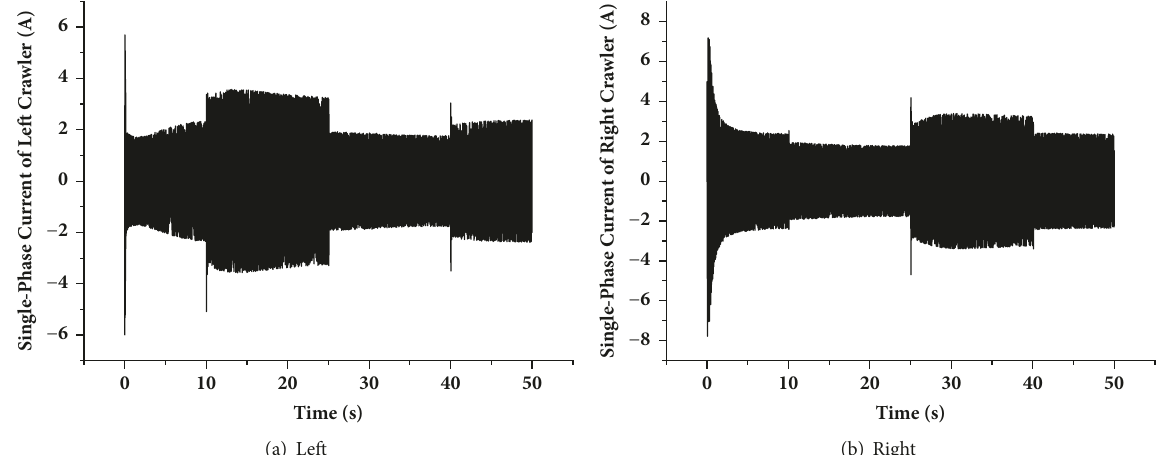
Figure 14: Single-phase current analysis of crawler